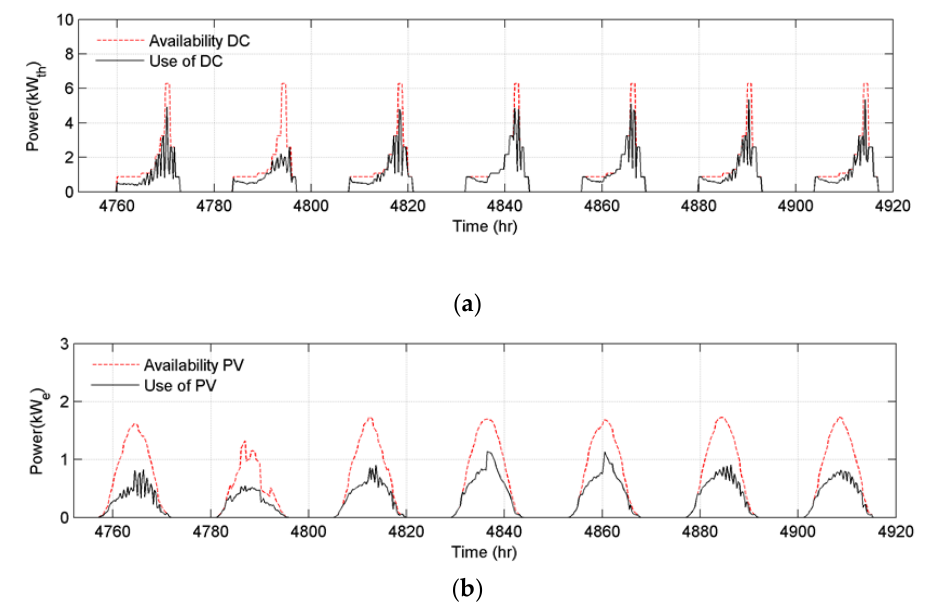
Figure 10. Energy sources used to cover the weekly cooling demand of the building compared to the availability profiles with MPC (OFG, PH of 18 h): ( a ) DC; ( b ) PV.